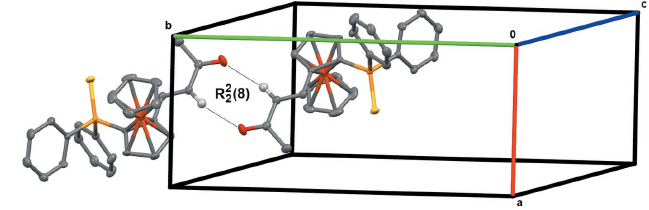
Figure 2 Partial packing view showing the formation of the R 2 arranged around the (1/2, 1, 1/2) inversion center.